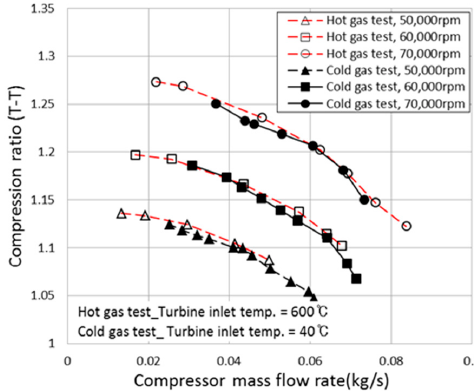
Figure 8. Comparison of compression pressure ratio results of cold and hot gas tests for compressor efficiency correction verification.